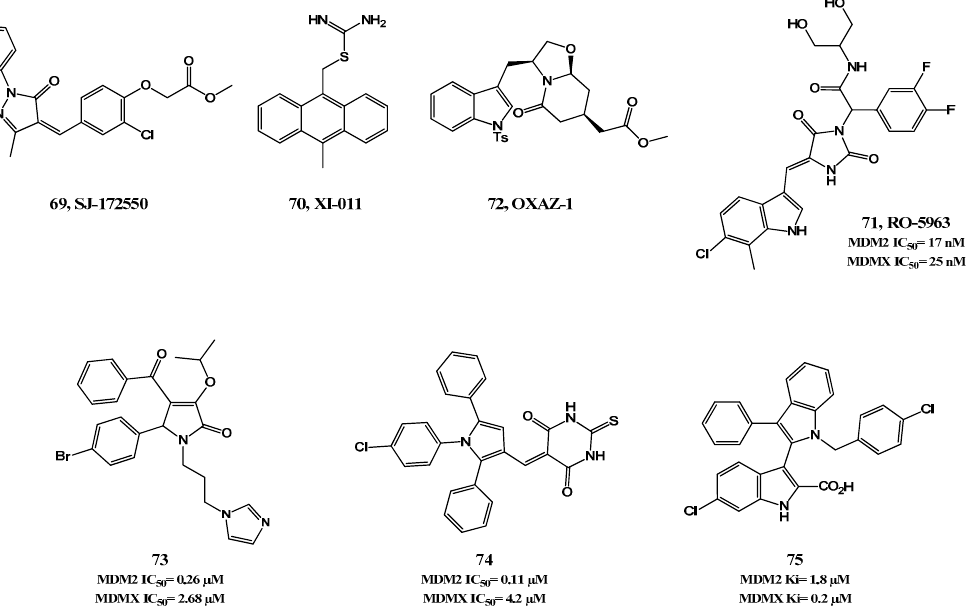
Figure 16. MDMX and dual MDM2/MDMX inhibitors.